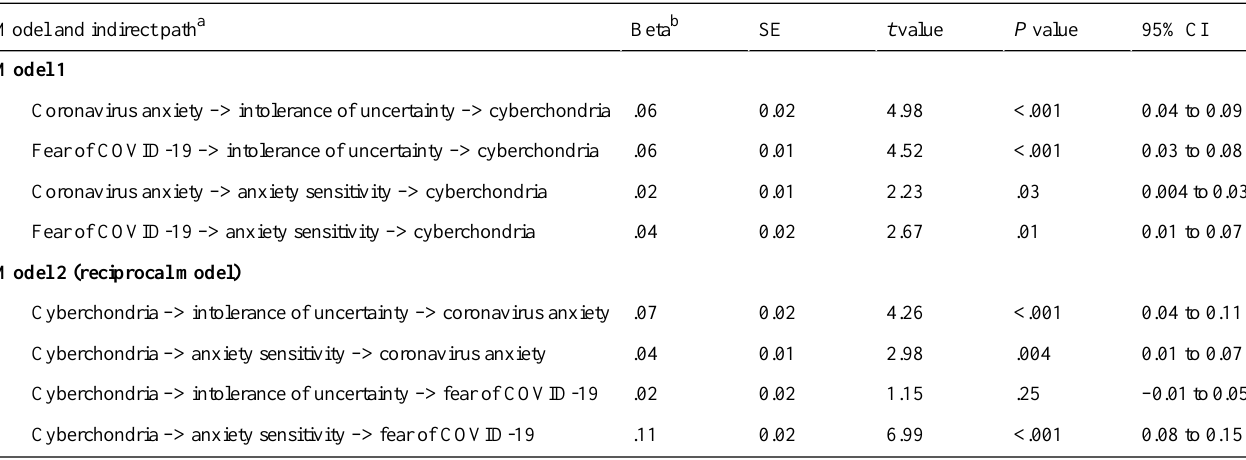
Table 3. Standardized indirect effects of model